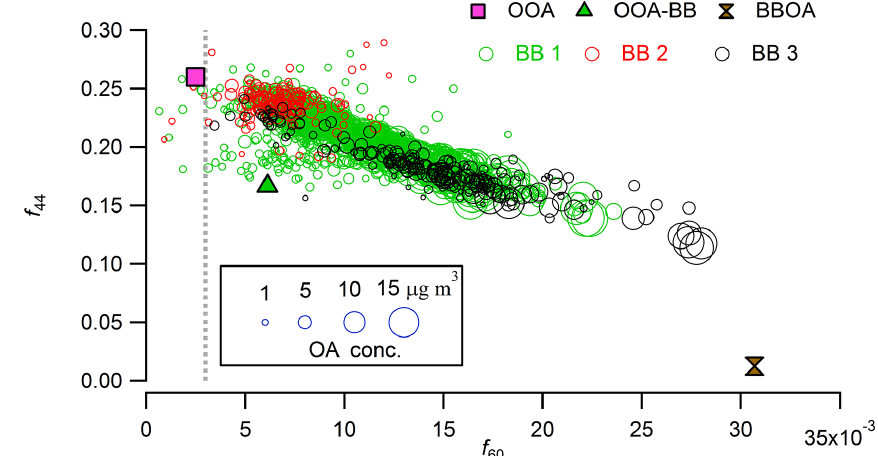
Figure 10. A triangle plot of f 44 as a function of f 60 ( f 44 vs. f 60 ) for the three biomass burning events; sized by OA